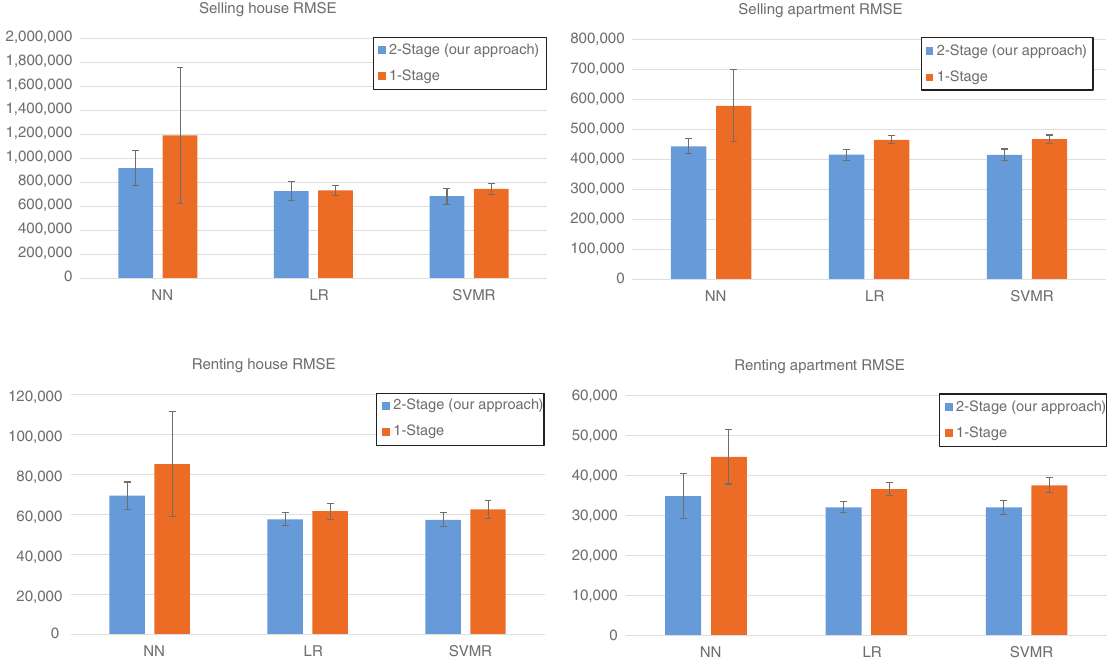
Figure 3: Summary of Results for the Four Data Sets (Selling House, Selling Apartment, Renting House, Renting Apartment) and the Three Regression Models of Stage 1 (LR, ANN, and SVMR). model in Stage